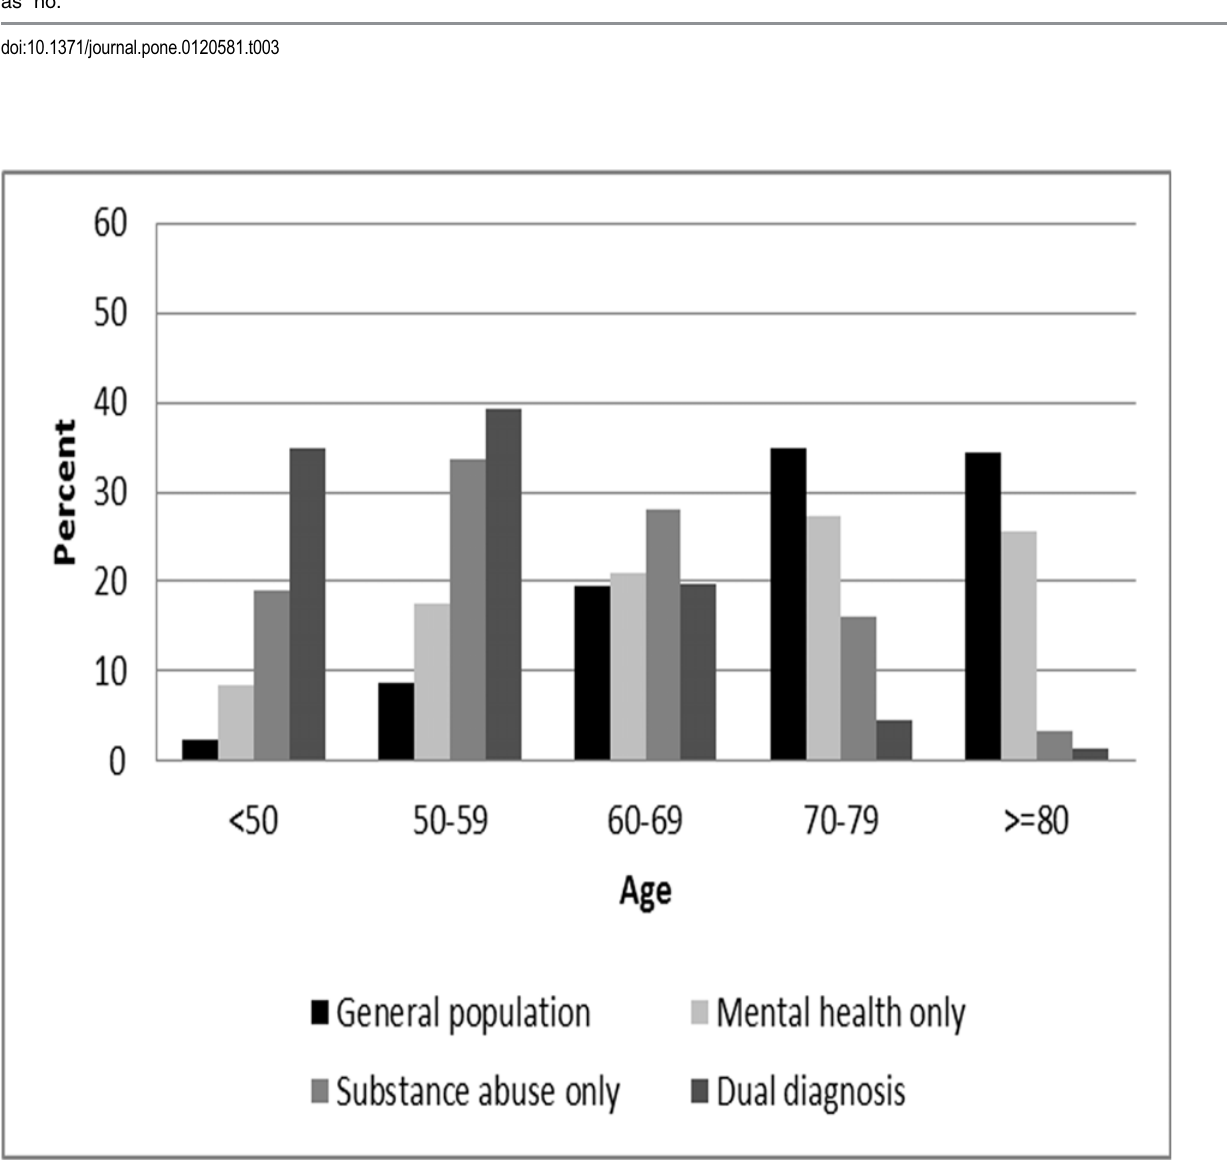
Fig 1. Tobacco-related deaths by age for Oregonians with mental health and/or substance abuse problems, 1999 – 2005 (N = 46,209).